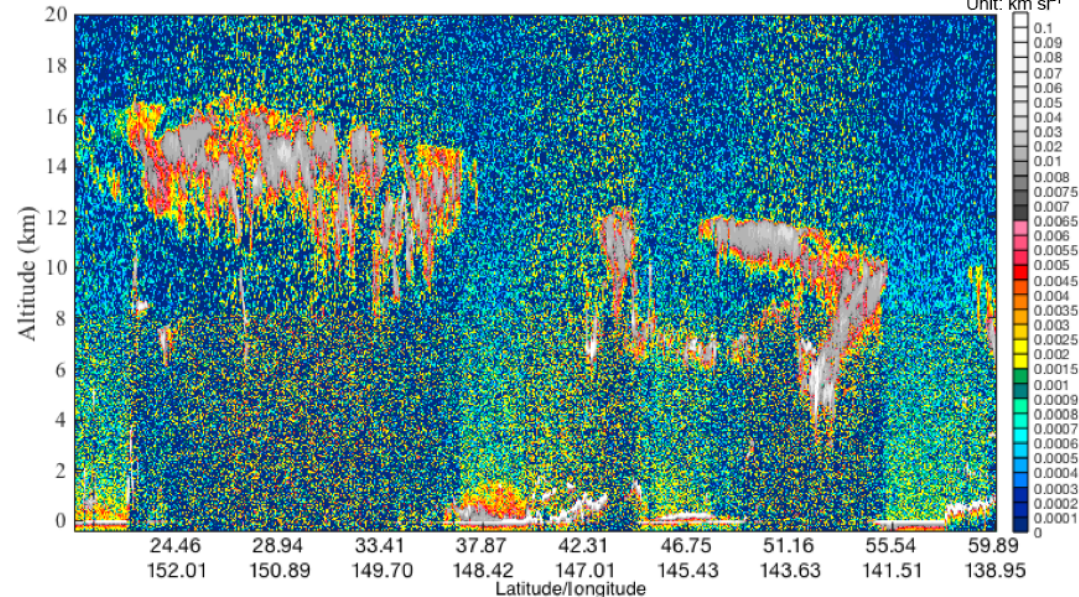
Figure 13. Total attenuated backscatter (km − 1 sr − 1 ) along the red line orbit shown in Fig. 11. The color bar on the right indicates the value of total attenuated backscatter.